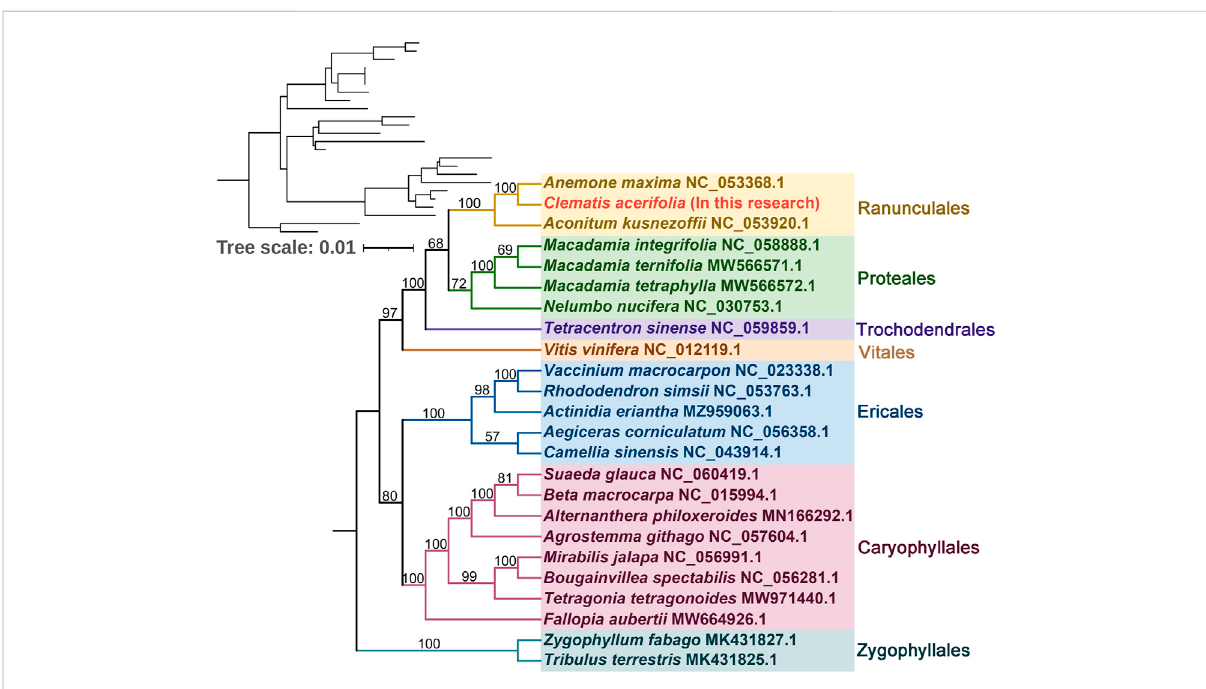
FIGURE 7 Phylogenetictreeof24angiospermsbasedonthesequencesof39conservedmitochondrialPCGs. Zygophyllumfabago and Tribulusterrestris were selected as outgroups. The number at each node is the bootstrap probability.